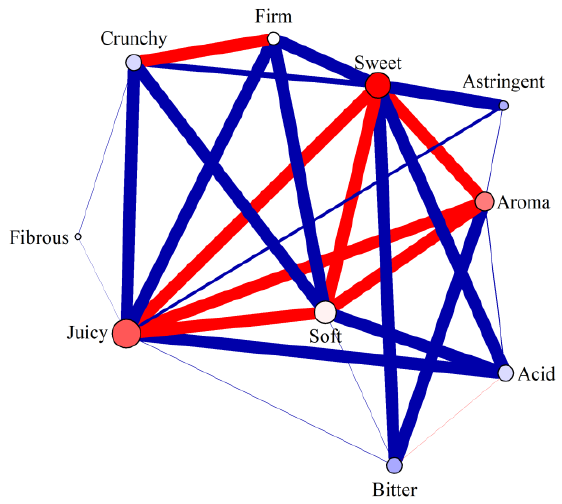
Figure 6. Co-occurrence frequency of peach characteristics. Only significant associations are shown; for a full list see Table S4. Edge widths are inversely proportional to p values (thick edges indicate low p values). Red edges indicate that a pair of nodes co-occurred more often than expected by chance; blue edges indicate they co-occurred less often than expected by chance. Node colour for each character is proportional to the corresponding parameter value in Figure 5: blue indicates a negative effect on hedonic rating and red a positive effect, while the strength of colour corresponds to the strength of the effect.